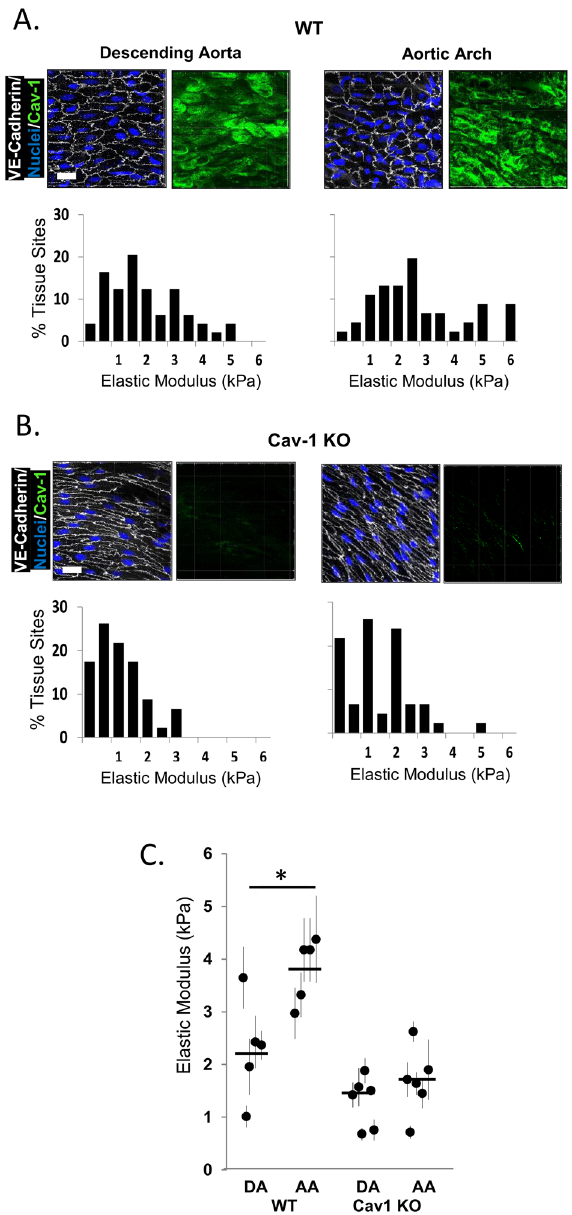
Figure 4. Absence of caveolin-1 abrogates endothelial stiffening in the pro-atherogenic aortic arch. ( A ) Histograms of elastic modulus values recorded from the descending aorta (left) and the aortic arch (right) of WT and ( B ) Cav-1 KO male 4 month old mice with representative confocal images to confirm lack of Cav-1 expression in Cav-1 KO mice (scale bars are 15 µm) and ( C ) data summary from AFM recording in ( A,B ) (Each circle is data from one mouse; error bars are SD from 10 to 15 measurements per aortic segment; horizontal line depicts mean of the total mice, n = 5–6 mice with 10–15 measurements per sample). *P < 0.05 by